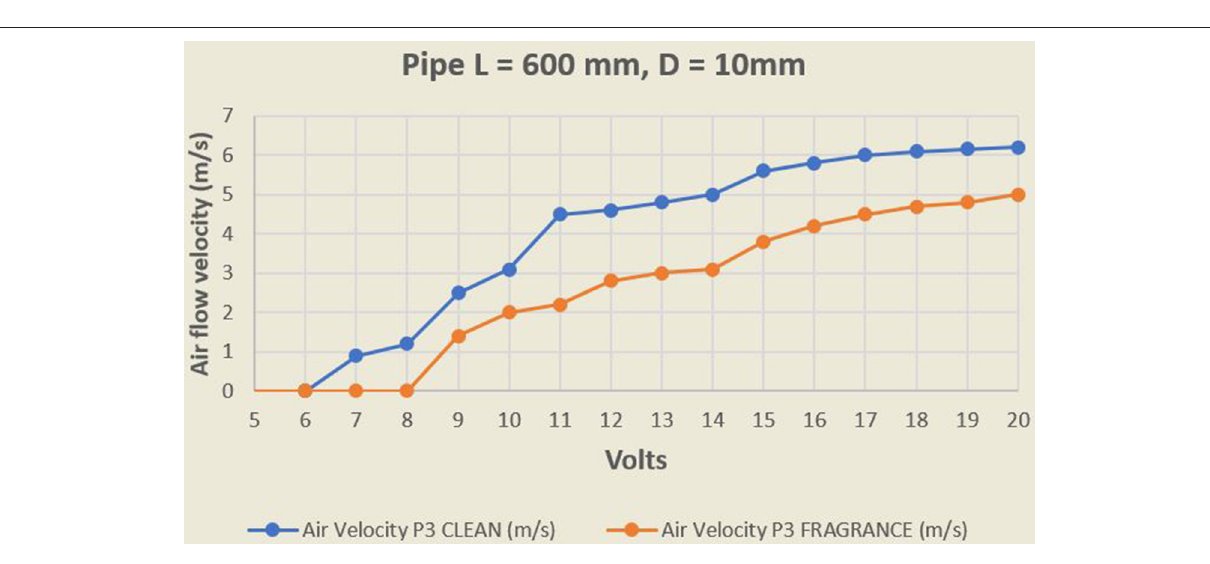
FIGURE 3 | Measurements taken at P3 with a tube 600mm long and 10mm